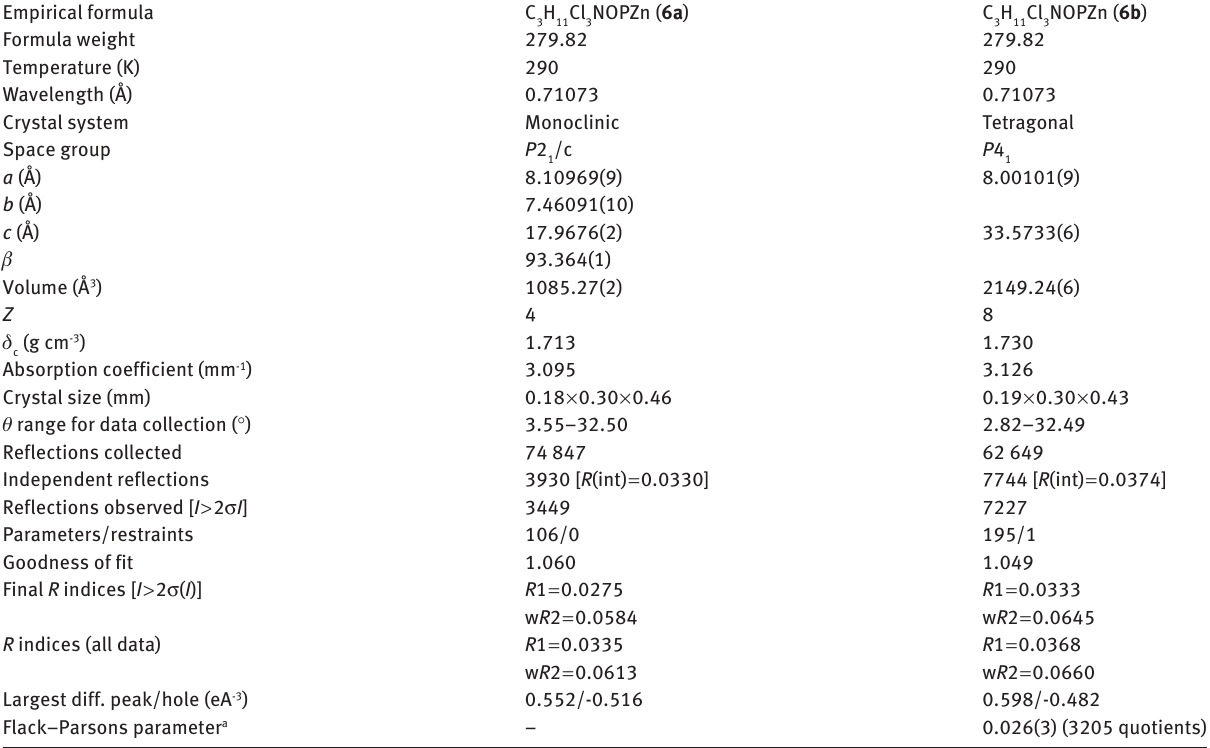
Table 2: Crystallographic